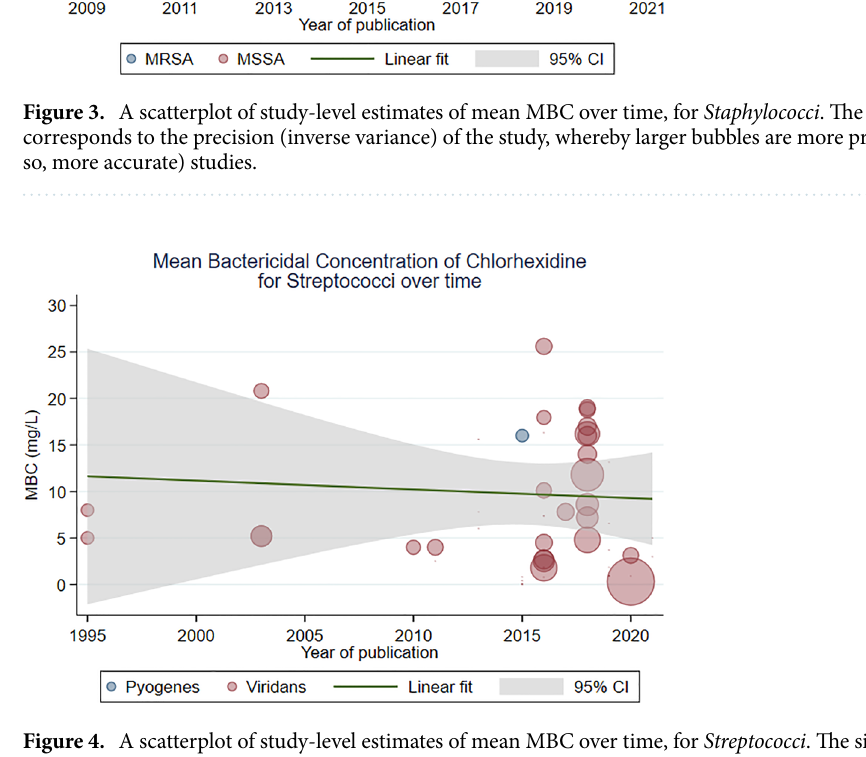
Figure 4. A scatterplot of study-level estimates of mean MBC over time, for Streptococci . The size of the points corresponds to the precision (inverse variance) of the study, whereby larger bubbles are more precise (bigger and so, more accurate)